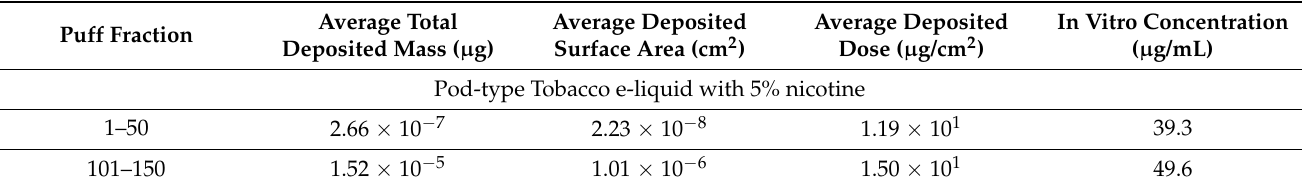
Table 2. Metrics of ENDS Aerosol Deposition within Human Lungs.